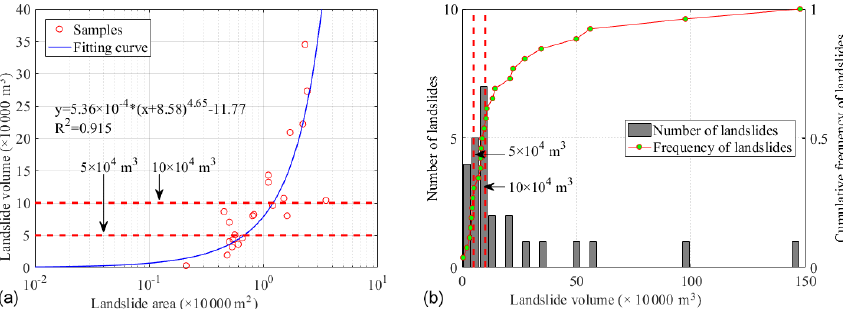
Figure 11. (a) Relationship between landslide volume and area ( R 2 = 0 . 915) used to convert magnitude–frequency relationships for the area to landslide volume. (b) Frequency distribution of landslide volume. The samples are presented in Table 2, involving the Chengguan database, except for the study